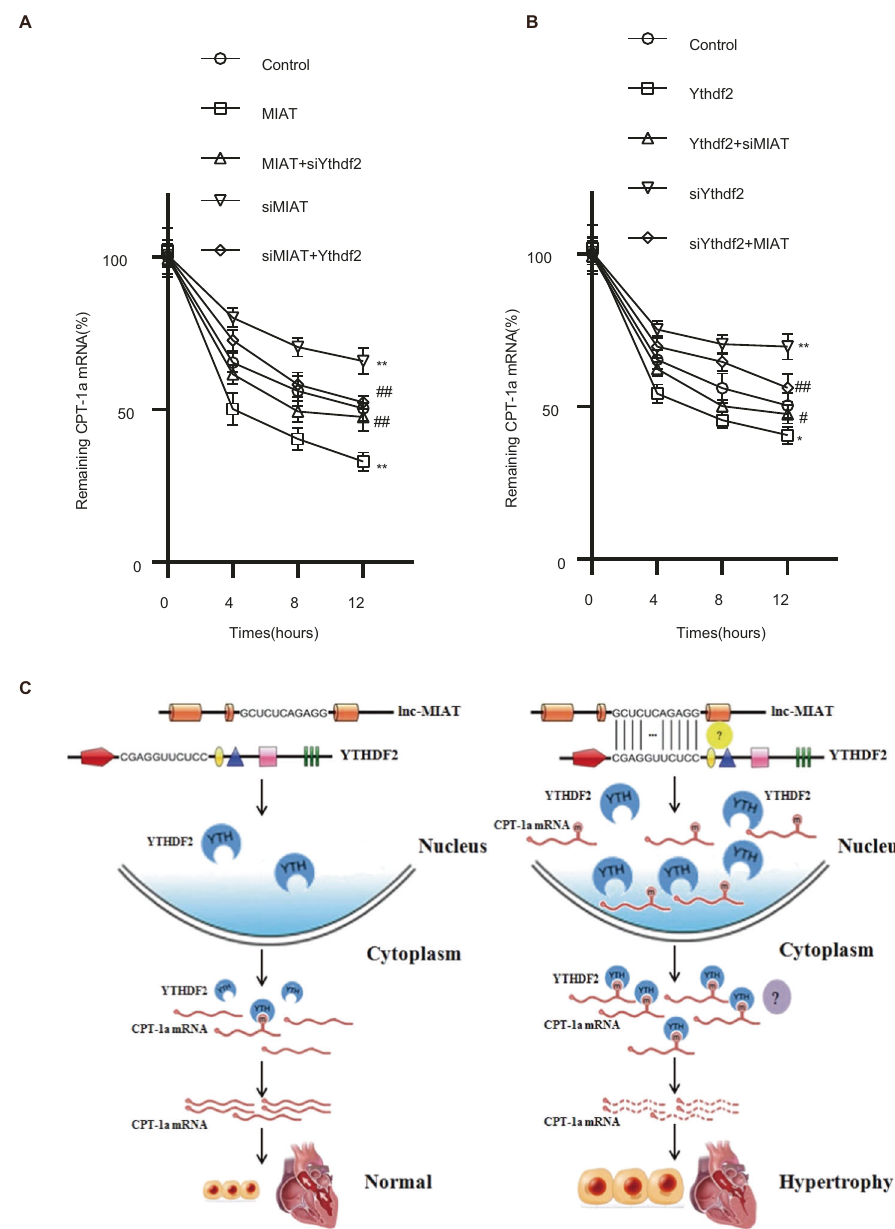
Fig. 6 MIAT regulated cardiac hypertrophy via the m 6 A methylation reading protein Ythdf2 to regulate CPT-1a m 6 A modi fi cation. A RNA stability assay was performed in actinomycin D-treated H9c2 cells transfected with above plasmid or siRNA. mRNA of CPT-1a was detected by RT-qPCR at 0, 4, 8, and 12 h. B Schematic fi gure revealing the proposed signaling pathway linking MIAT, Ythdf2, CPT-1a to CH. C A proposed model showing MIAT regulates CPT-1a induced cardiac hypertrophy through